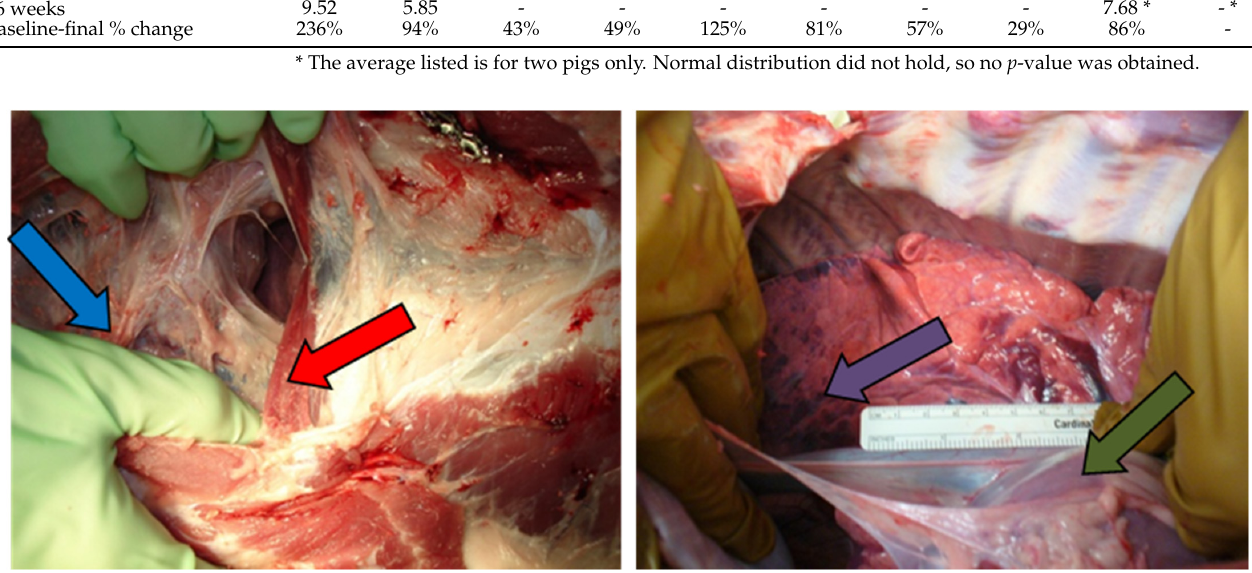
thickness (red arrow), abnormal color in the lungs (purple arrow), and increased pericardium ness (green arrow).